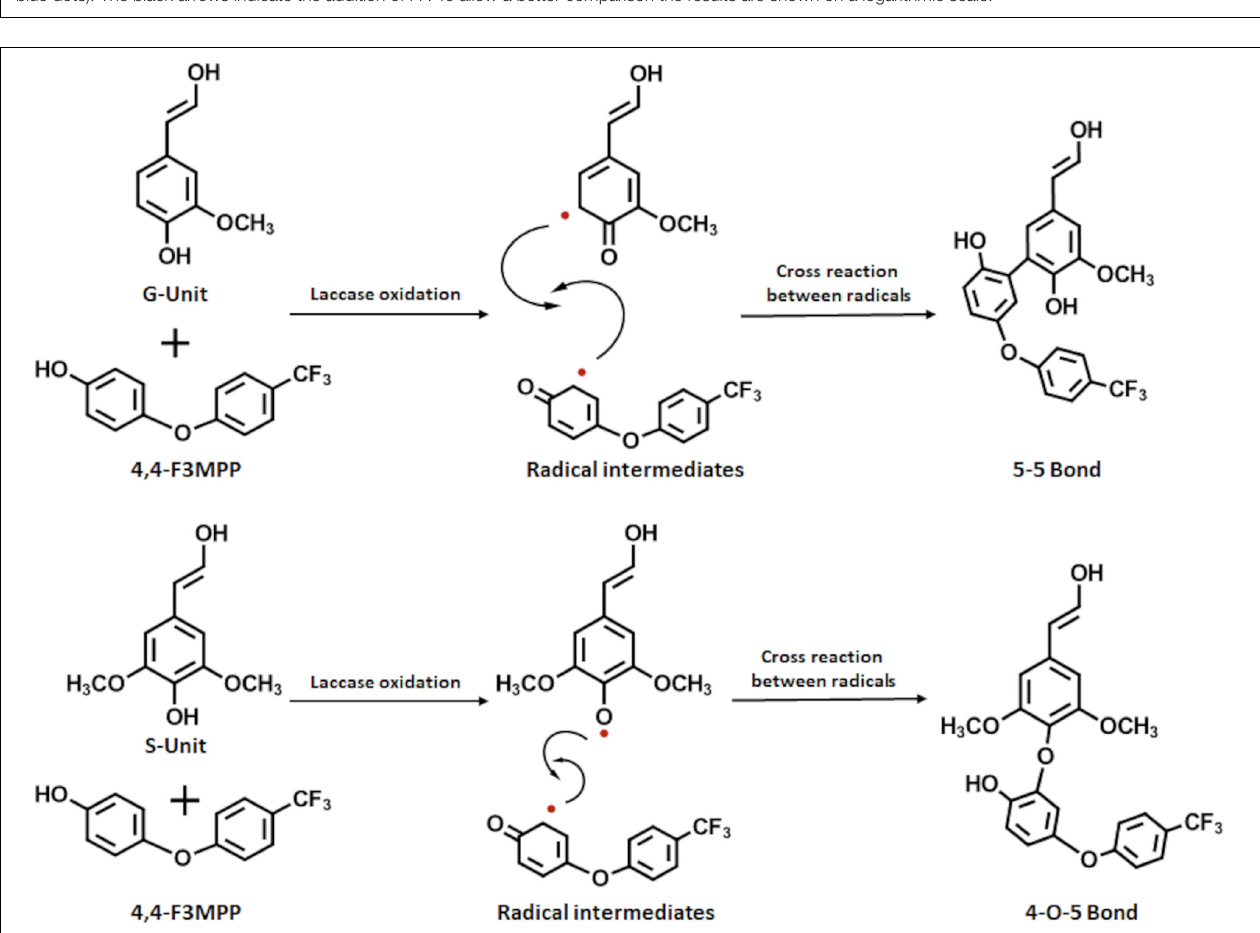
FIGURE 5 | Changes in viscosity (A) and molecular weight (B) during laccase catalyzed coupling of FP onto LS at a pH of 7, 33 ◦ C and different concentrations of FP added. Shown are the 1% (w/v) FP sample (filled orange squares), the 2% (w/v) FP sample (filled blue dots) and the respective control samples (orange squares and blue dots). The black arrows indicate the addition of FP. To allow a better comparison the results are shown on a logarithmic scale.